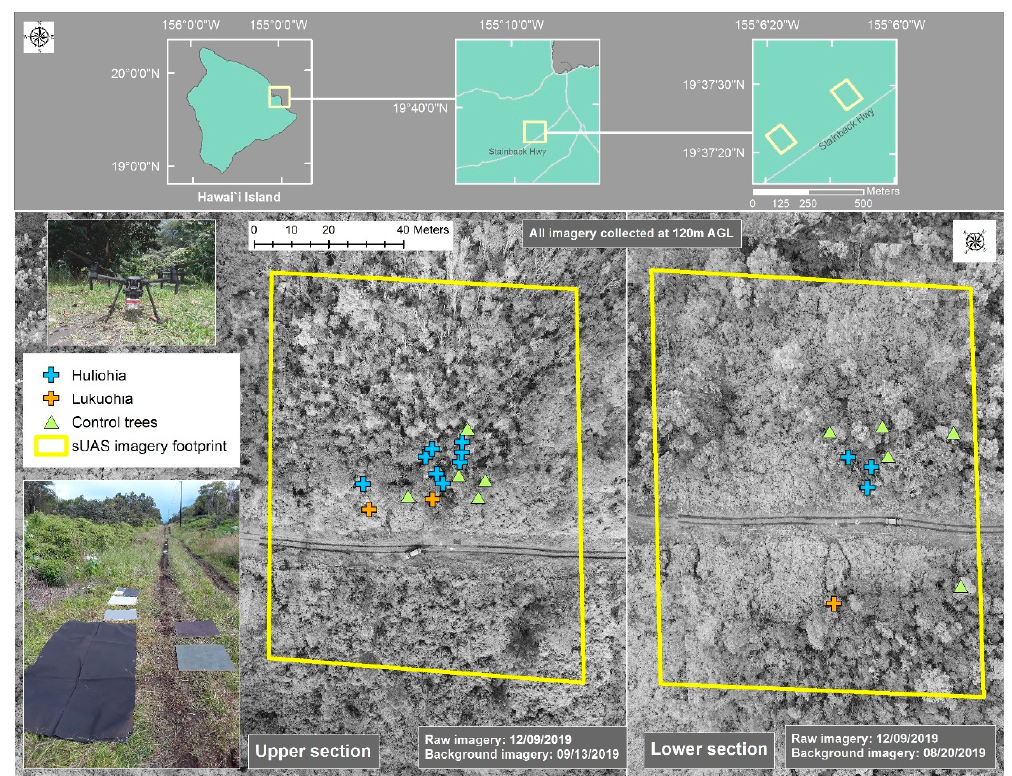
Figure 4. Study site, tree locations, upper and lower areas, footprint of single Altum/red green blue (RGB) image.